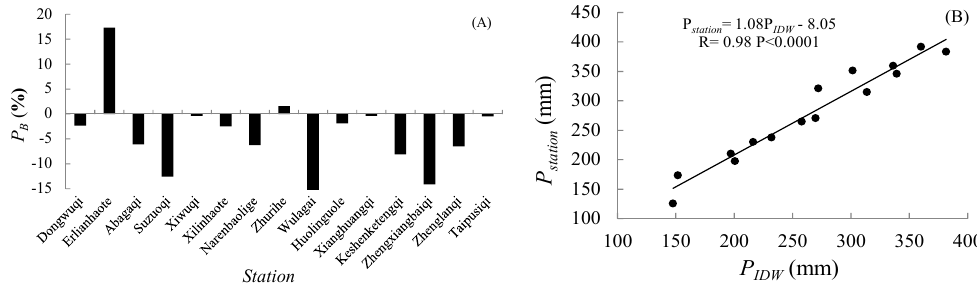
Figure 2. Relationship between the observed annual average precipitation and Inverse Distance Weighted (IDW) interpolated precipitation: ( A ) shows the bias; ( B ) shows the linear relationship.